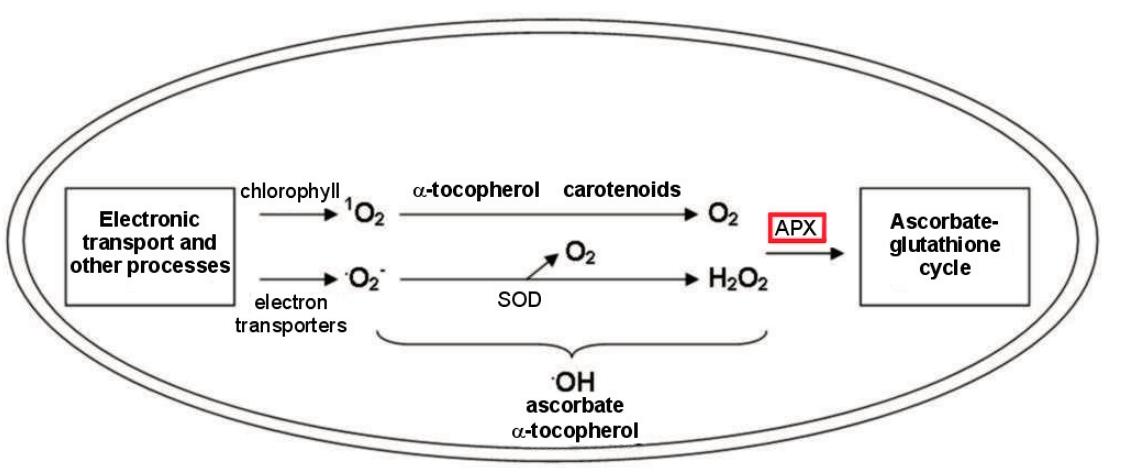
Figure 3. Production and scavenging of ROS in chloroplasts of plants subjected to